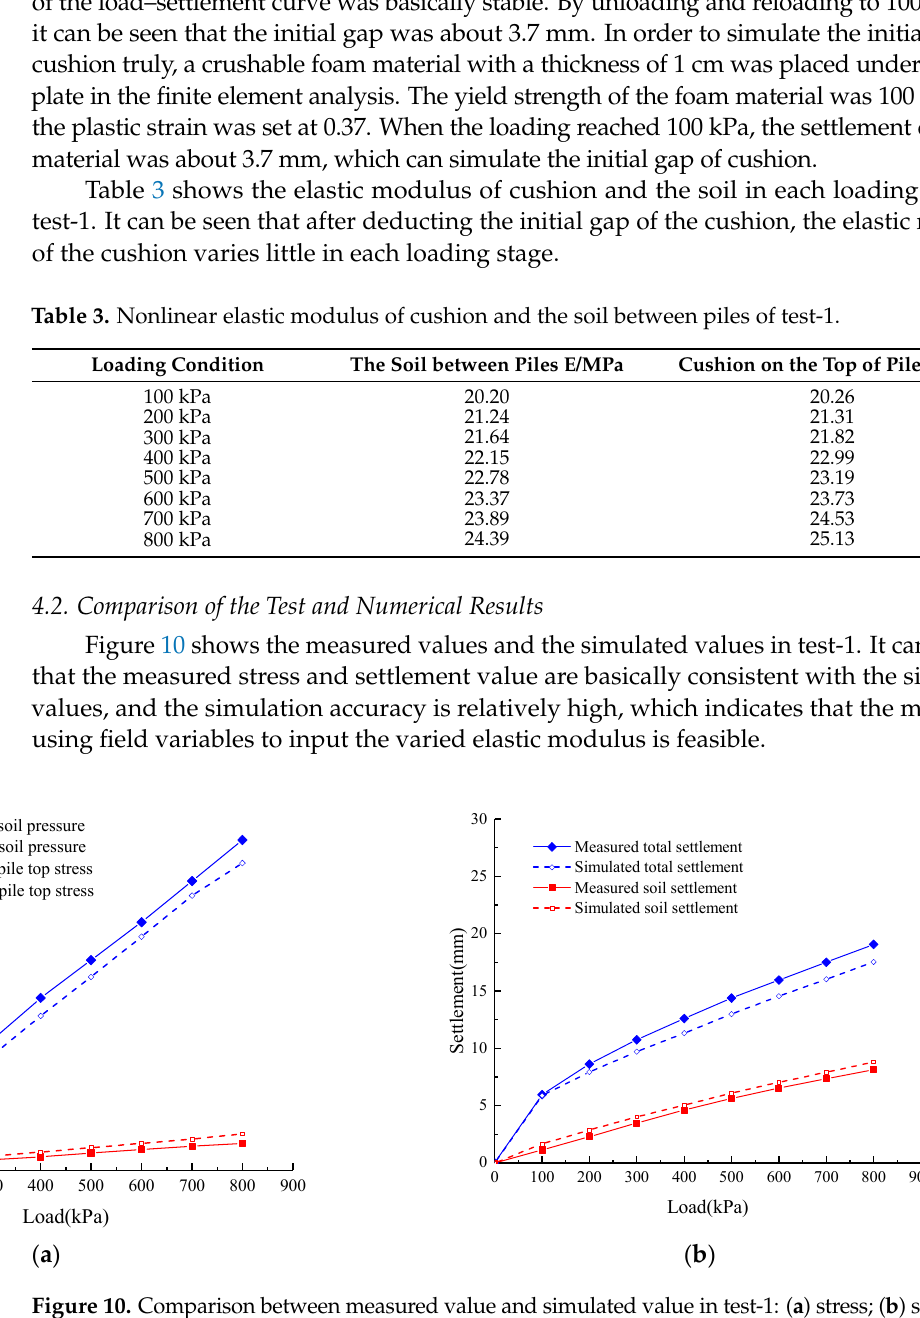
( b ) Figure 11. Finite element simulation results in test-1: ( a ) settlement contour (m); ( b ) stress contour (Pa).